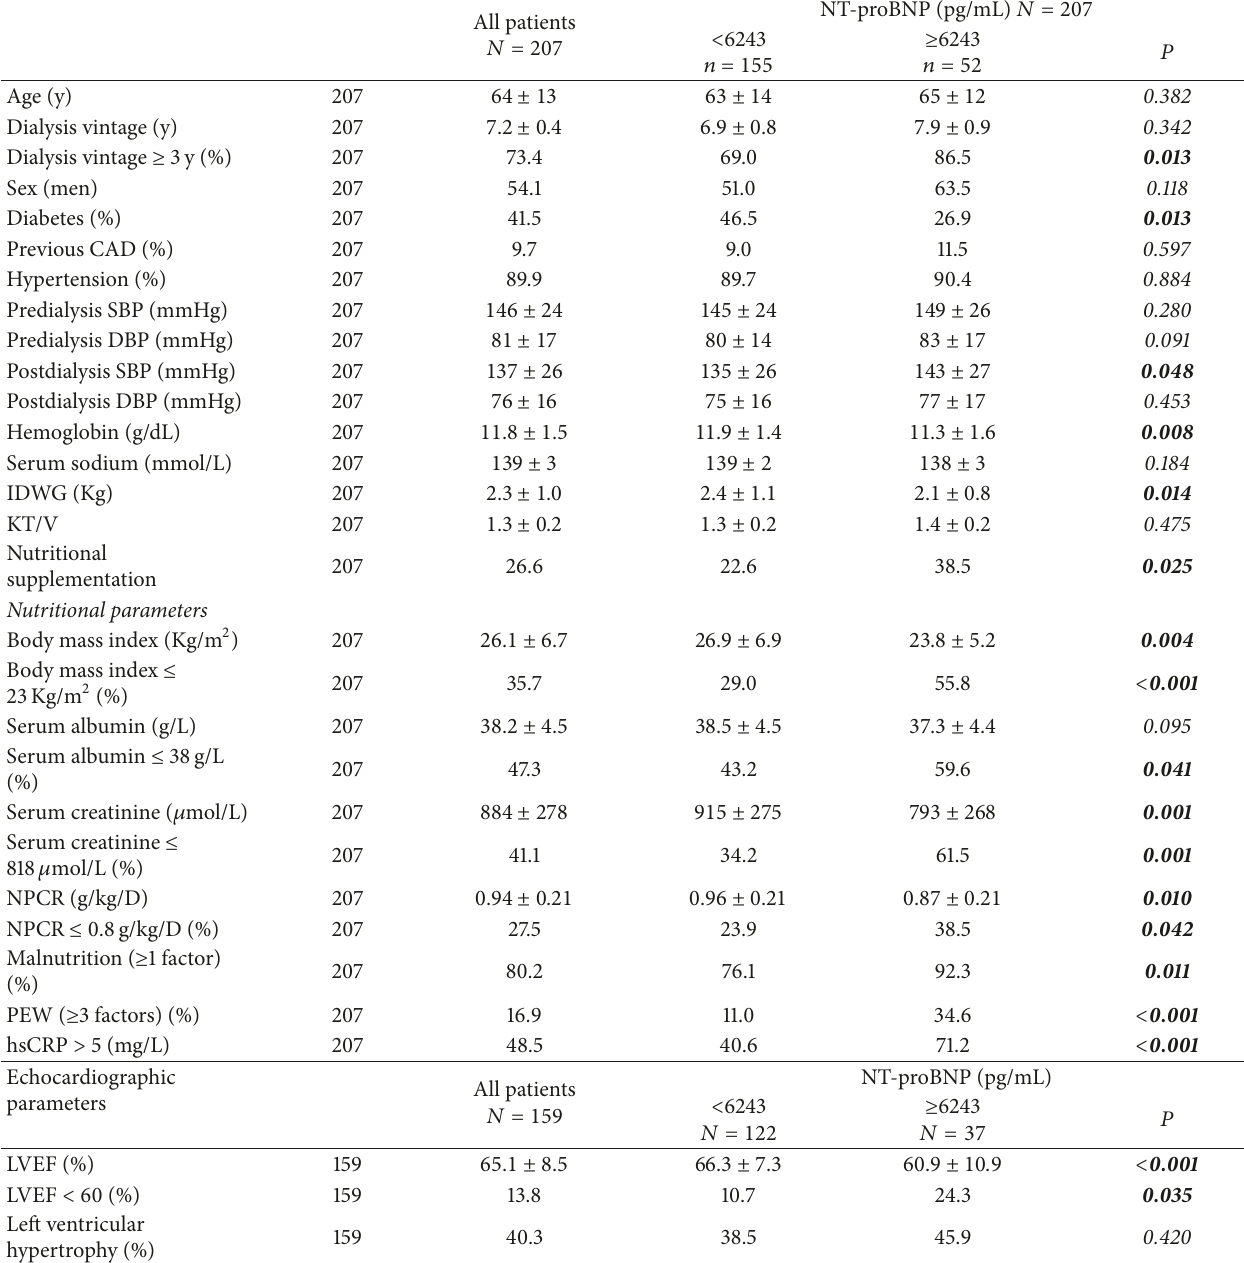
Table 1: Characteristics of hemodialysis patients according to NT-proBNP levels. All patients 𝑁 =